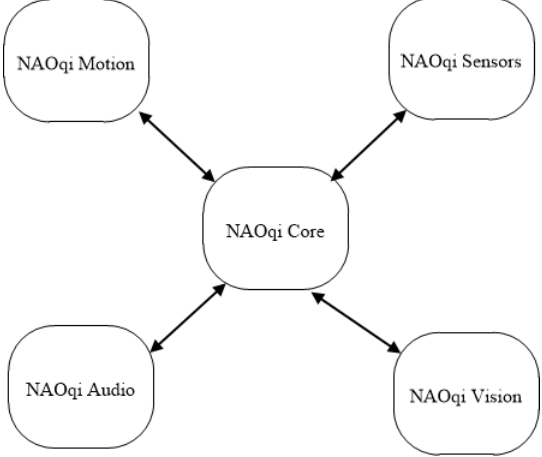
Figure 7. Employed NAOqi modules.